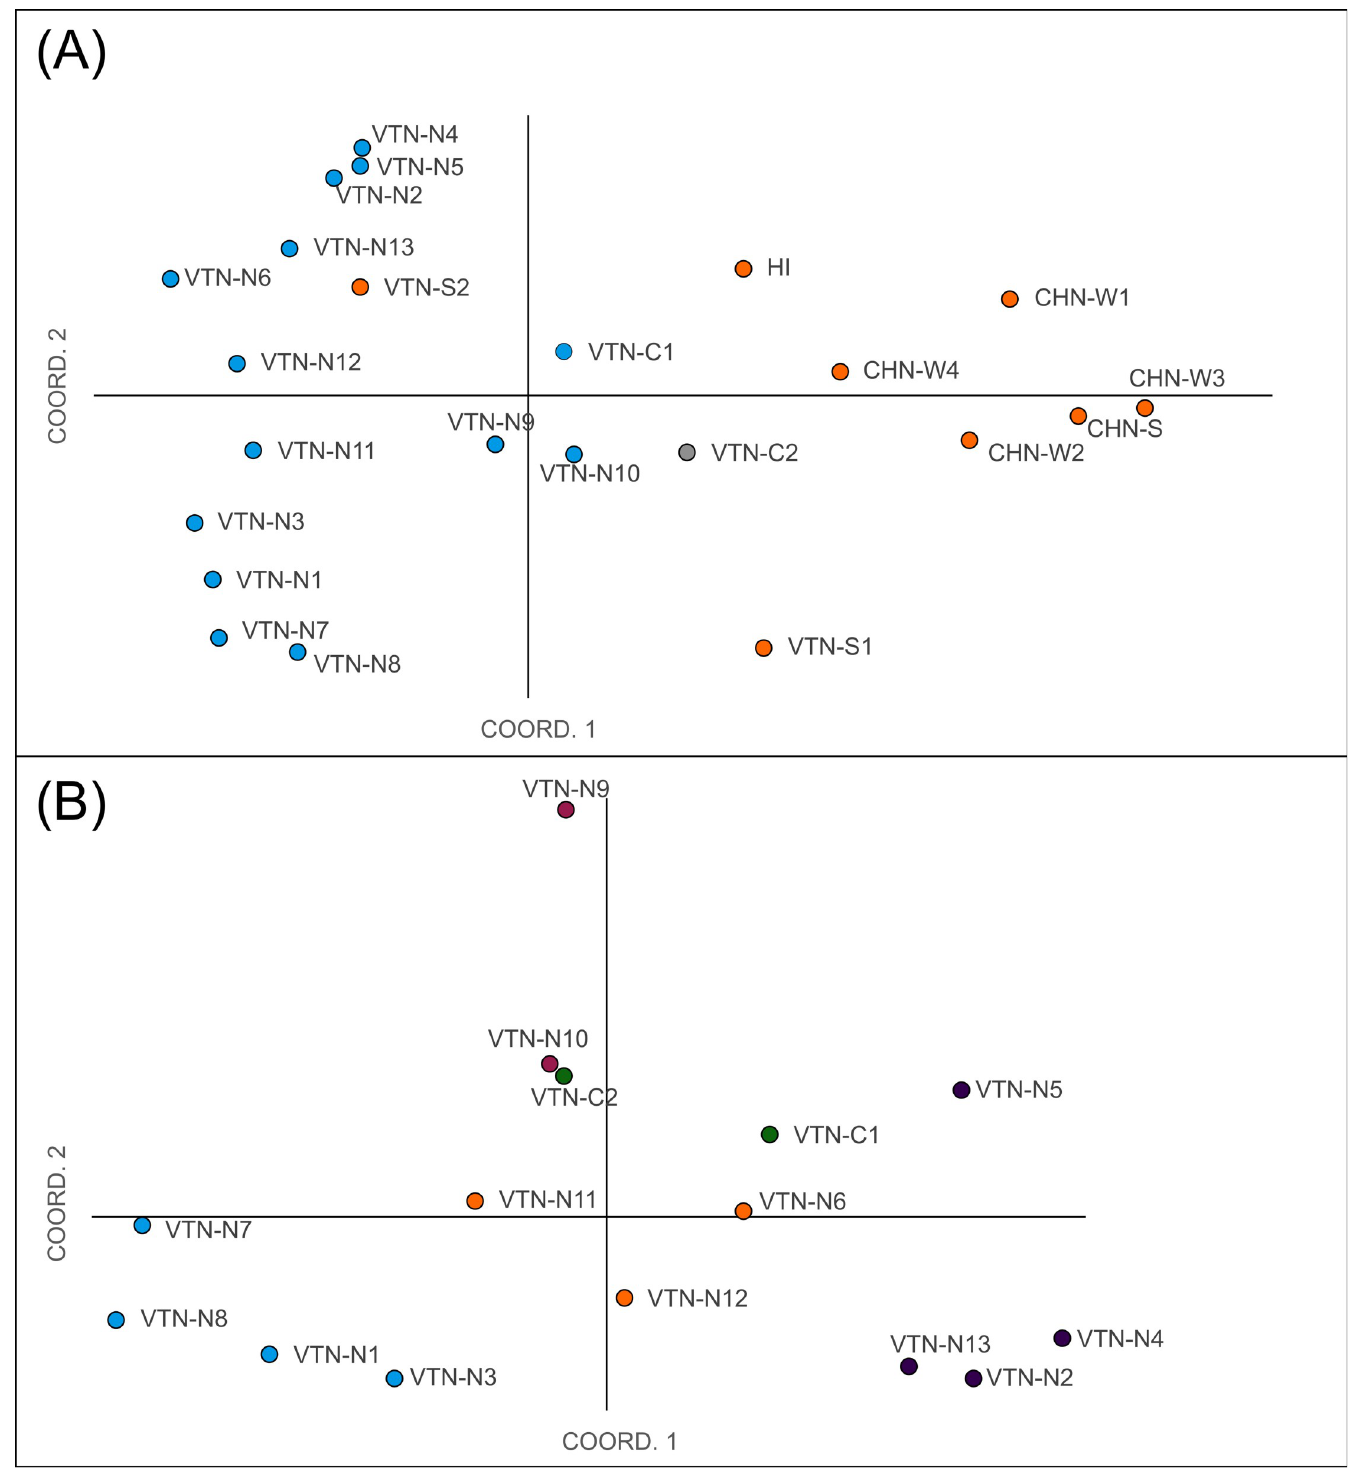
Fig 2. Principal coordinate analysis of wild populations of Musa balbisiana based on a Codom genotypic genetic distance matrix. (A), full dataset; (B), Native Vietnamese populations. Colours are based on cluster assignments of the STRUCTURE analyses below (see Fig 3).